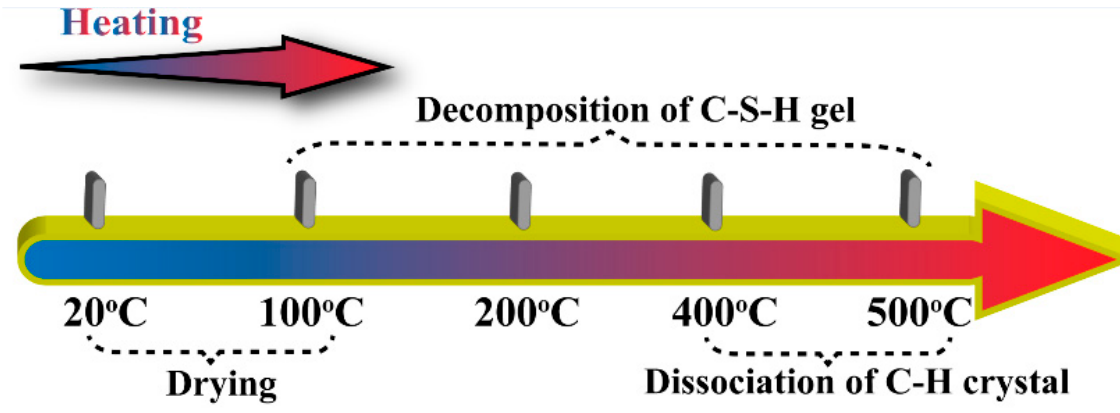
Figure 7. Effect of the elevated temperature on concrete.